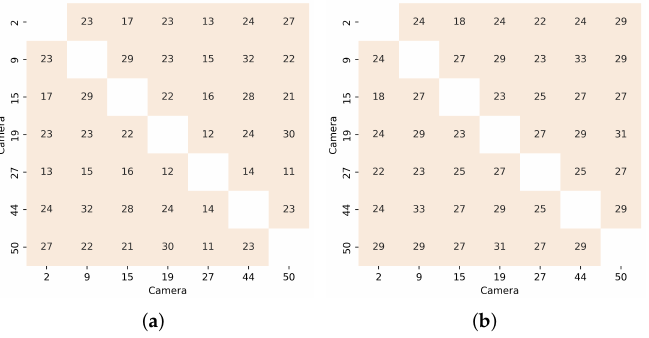
Figure 8. Confusion Matrices using PSNR metric which the higher the score, the more similar the pair of images are: ( a ) Original images (no color correction); ( b ) Corrected images with proposed